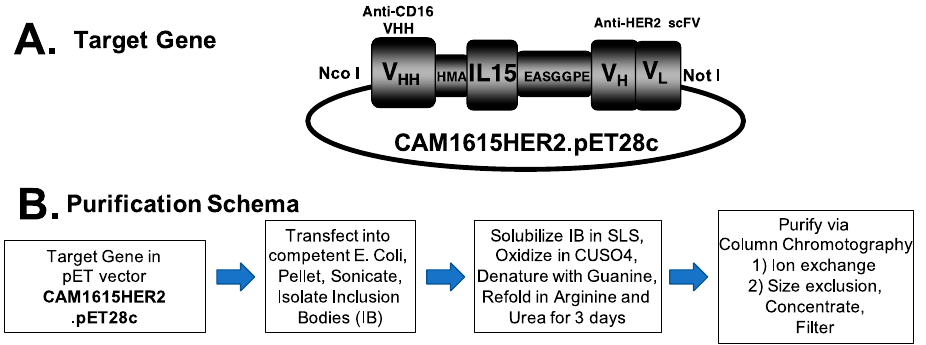
Figure 1. Methodology for generation of CAM1615HER2 TriKE. ( A ) Schematic depicting CAM1615HER2 consisting of (left to right) camelid anti-CD16 VHH, human IL-15, and anti-HER2 scFv. ( B ) Flow chart of TriKE production and purification schema.